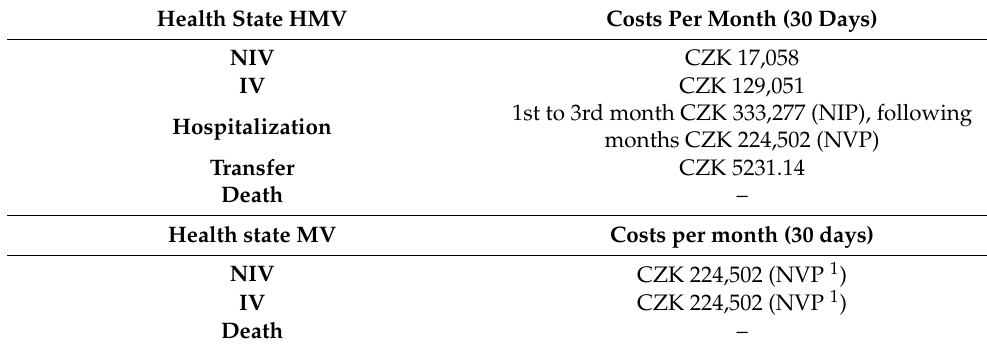
Table 6. The costs used in the care